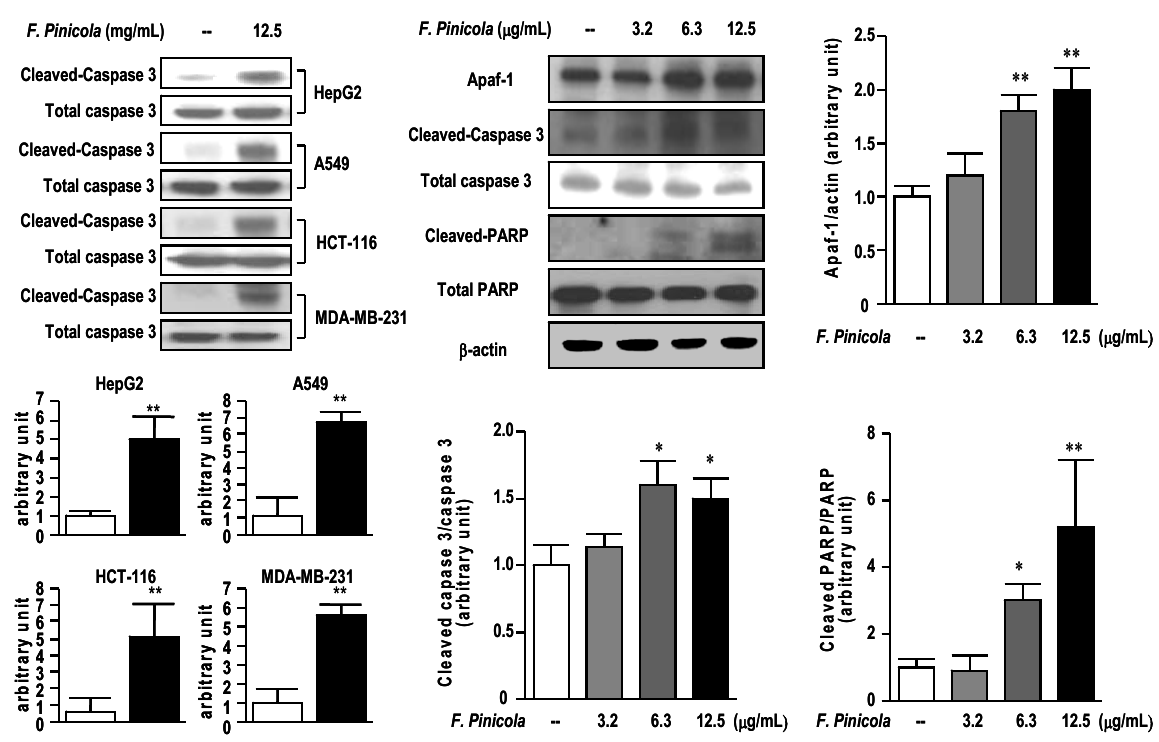
Figure 3. Ethanol extract of F. pinicola induced apoptosis to exert anti-tumor effect in cancer cells. Different human cancer cell lines as indicated were treated with 12.5 µg/mL F. pinicola ethanol extract for 18 h. The cleaved-caspase 3 levels were detected by western blots ( left panel). Mouse sarcoma S-180 cells were treated with 12.5 µg/mL F. pinicola ethanol extract for 18 h. The apoptosis-related protein expressions were detected by Western blots ( middle and right panels). * p < 0.05, and ** p < 0.01 compared with the control